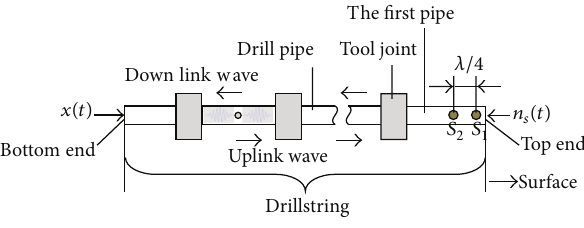
Figure 2: Schematic diagram of the AEC using two